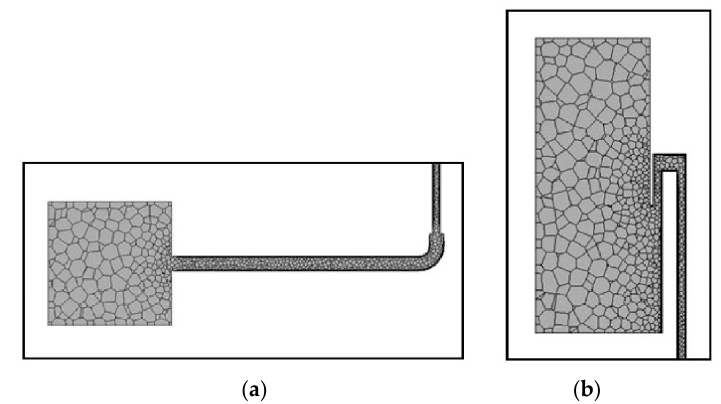
Figure 4. Vertical sections of the inlet ( a ) and outlet ( b ) volumes mesh.